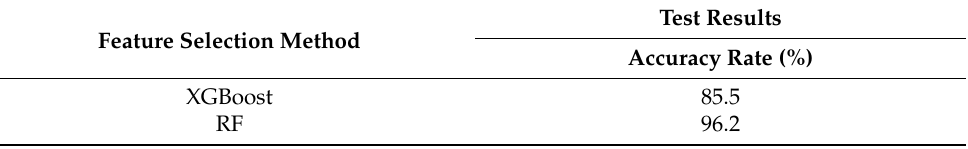
Table 8. LightGBM results after XGBoost and RF feature screening.